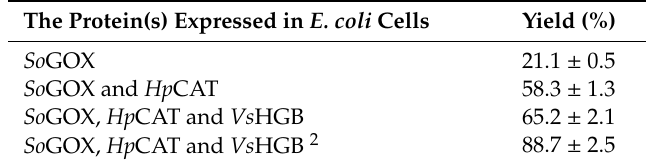
Figure 1. SDS-PAGE analysis of glycolate oxidase So GOX, catalase Hp CAT and/or hemoglobin Vs HGB in the crude extracts. Lane M, marker; lane 1, no induction of the cells co-expressing So GOX, Hp CAT or Vs HGB as the control; lane 2, expression of So GOX (~40 kDa) alone; lane 3, co-expression of So GOX and HpCAT (~54 kDa); lane 4, co-expression of So GOX, Hp CAT and Vs HGB (~16 kDa). The crude extract samples were run by PAGE (12% acrylamide) and stained with Coomassie Brilliant Blue R-250. Table 1. Oxidation of methyl glycolate to methyl glyoxylate catalyzed by crude extracts expressing So GOX, Hp CAT and/or Vs HGB. 1